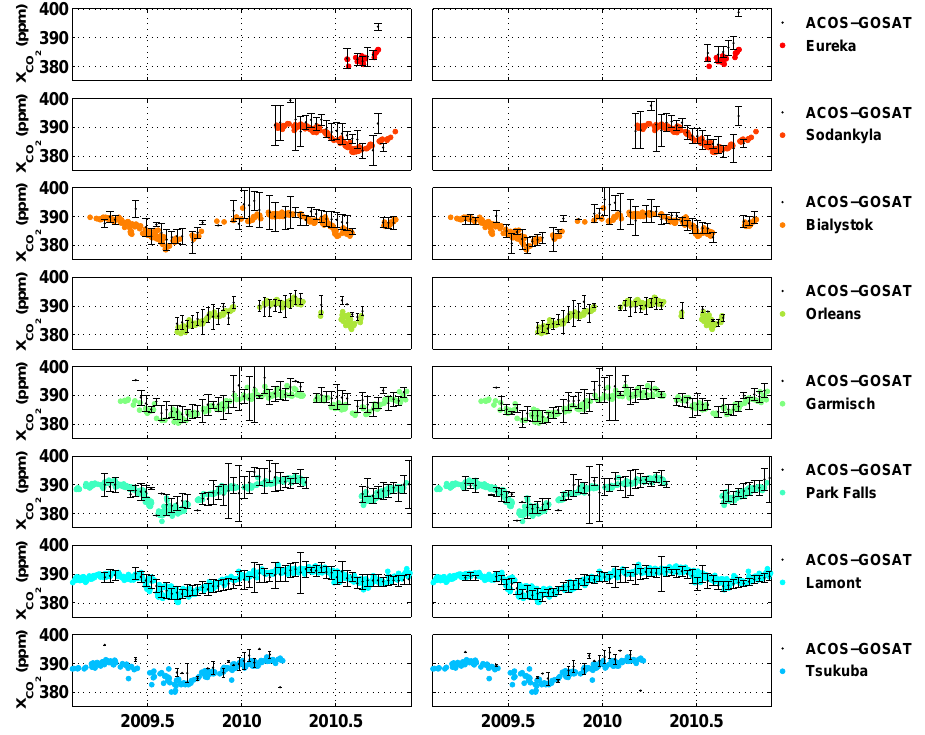
Fig. 16. A site-by-site comparison between ACOS-GOSAT and the Northern Hemisphere TCCON sites, using the T 700 coincidence criterion (data recorded within 10 days, ± 10° latitude, ± 30° longitude and ± 2K). The left panel shows the ACOS-GOSAT data after applying the global bias (0.982), and the right panel shows the data after applying Eq. (4).